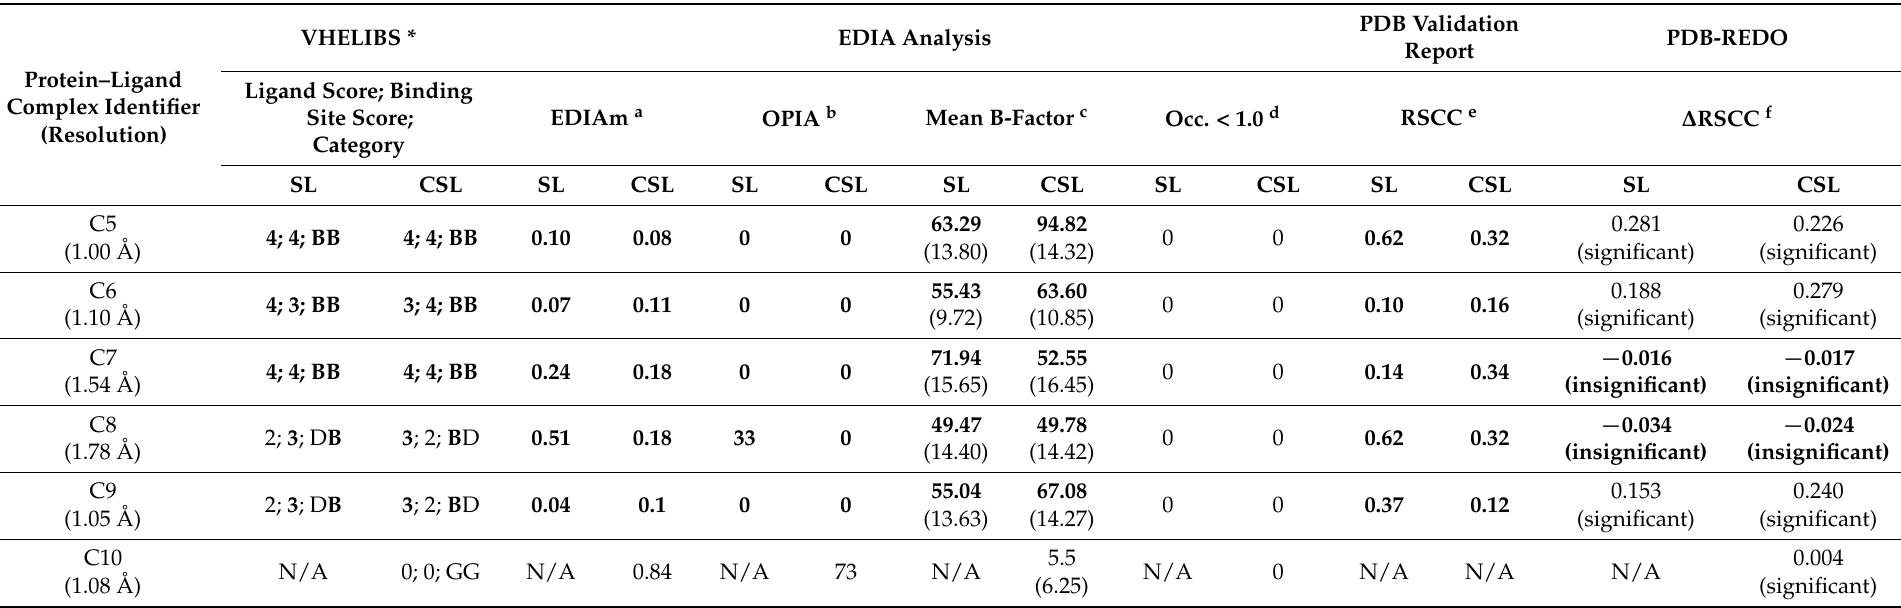
Table 2. Quality assessment of ligands bound to the structures C5–C10 (case